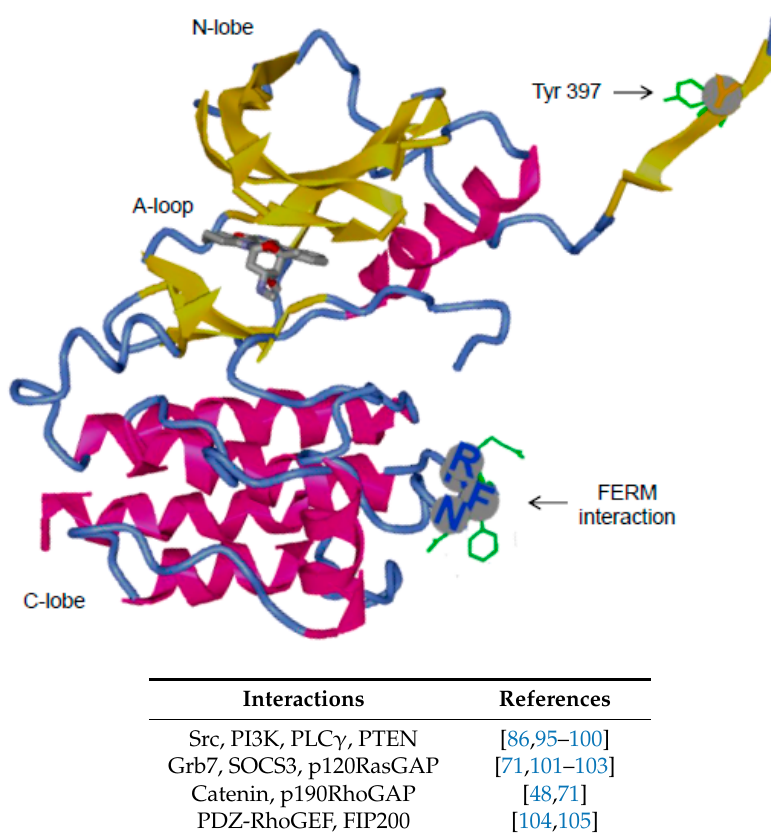
Figure 3. Structure of the kinase domain of FAK from the protein databank (accession code 2JOJ). The kinase domain displays the C lobe, N lobe and the activation loop. In the C lobe, residues important for FAK auto-inhibition that interact with the F2 lobe of the FERM domain are highlighted and their side chains coloured in green. Proteins associating with P-Tyr397 and the kinase domain are shown in the table.